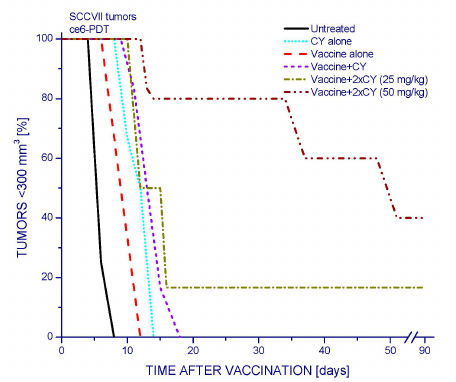
Figure 3. The impact of twice injected cyclophosphamide on the efficacy of PDT vaccine. Cyclophosphamide (25 or 50 mg/kg i.p.) was injected at two days before and four days post vaccination performed as described for Figure 1, and the same without vaccination was done for “CY alone” group; the higher dose single treatment (“Vaccine+CY group”) was done at two days pre vaccination. The results are presented as percentages of mice with tumors smaller than 300 mm 3 in function of time after vaccination; mice surviving at 90 days post therapy are by convention considered cured. Each treatment group consisted of six mice. Statistically significant ( p < 0.05) were the differences between the control untreated group response and all five treatment group responses, between vaccine alone response and all three vaccine plus cyclophosphamide groups’ responses.